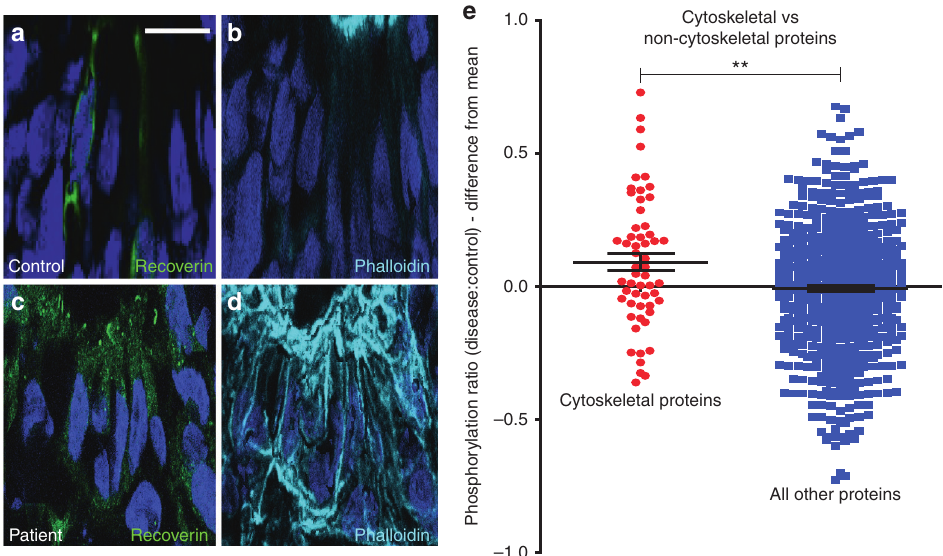
Fig. 2 RPGR -mutant, iPSC-derived, 3-dimensional photoreceptor cultures display perturbed actin regulation. a – d RPGR -mutant photoreceptors display increased actin polymerisation, as evidenced by increased phalloidin binding in the Recoverin-positive photoreceptors of patient-derived cultures (panels c , d ) as compared to photoreceptors from the control patient (panels a , b ). See text for details of quanti fi cation of pixel intensities. Nuclei stained with Hoechst ( blue ). e The mean phosphorylation level of cytoskeletal regulatory proteins was higher in RPGR /XLRP photoreceptors compared to control photoreceptors ( red dots ; 0.092 ± 0.0033, n = 56 proteins). This was signi fi cantly more than the mean ratio of phosphorylation levels of non-cytoskeletal proteins when RPGR /XLRP photoreceptors were compared to control ( blue dots ; − 0.008 ± 0.01, n = 583 proteins, unpaired, two-tailed t -test, p = 0.004 (** = p <